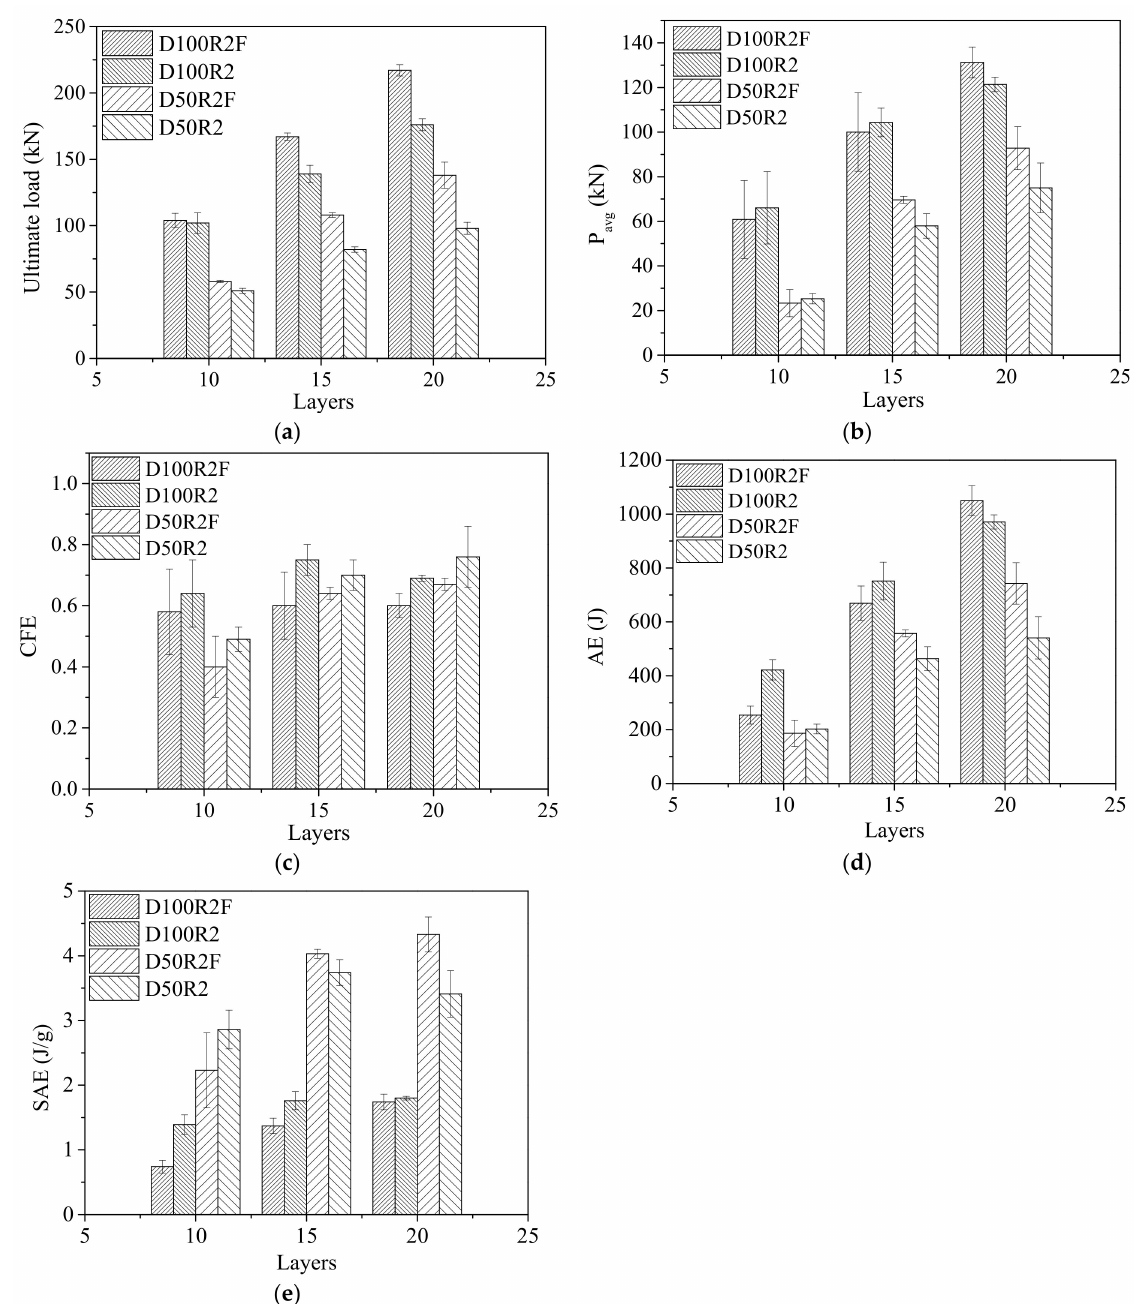
Figure 8. Effect of foam filler on evaluation indices of the energy absorption of bamboo composite tubes. ( a ) Ultimate load; ( b ) average crush load; ( c ) crush force efficiency; ( d ) absorbed energy; ( e ) specific absorbed